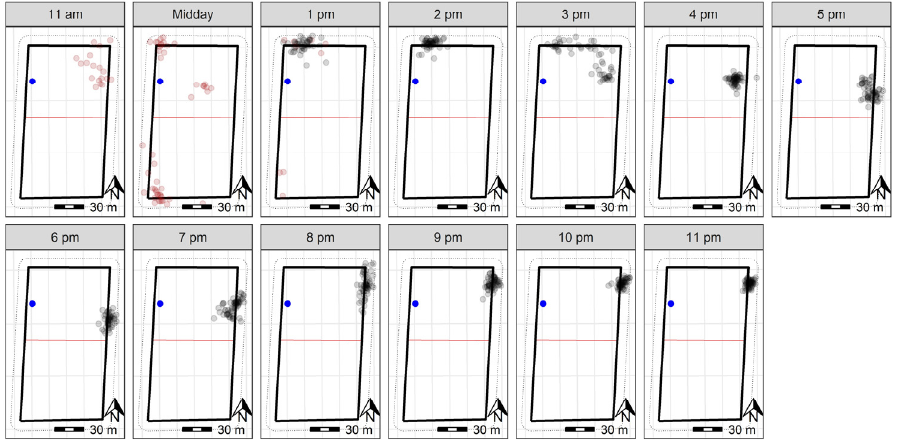
Figure 3. GPS plots across 11 h on day one of the trial for 10 sheep at Lameroo, with the training period indicated in red datapoints and the water point indicated in blue. The grey points (or red during training) indicate the GPS positions (measured every 10 min) of individual sheep throughout the day. Darker points indicate point overlay in locations where sheep were registered more frequently. The solid black rectangle indicates the wire fenced paddock boundary, with the red line representing the virtual fence. The dashed lines on the outside of the paddock boundary indicate the 10 m buffer zone used to clip the data to remove recording errors based on GPS drift. A scale is included to indicate paddock size.